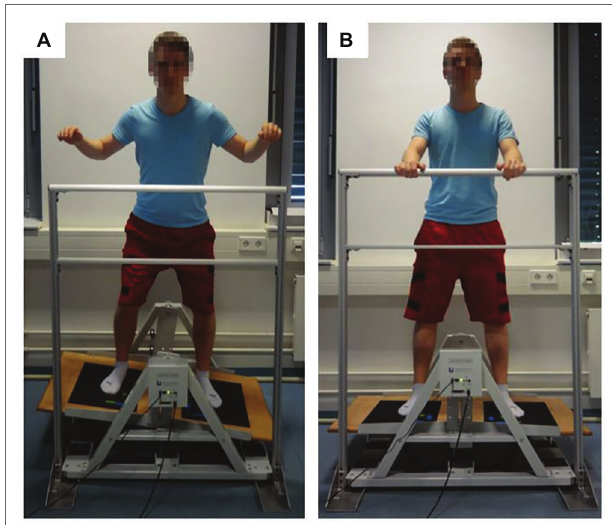
FIGURE 1 | Depiction of a subject balancing (A) and standing (B) on the stabilometer (stability